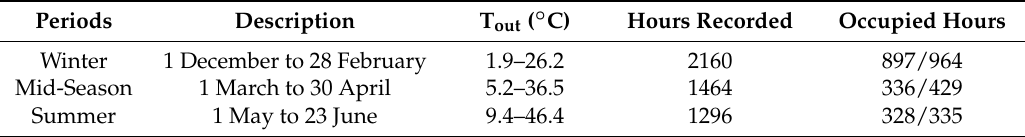
Table 4. Characteristics of protocols